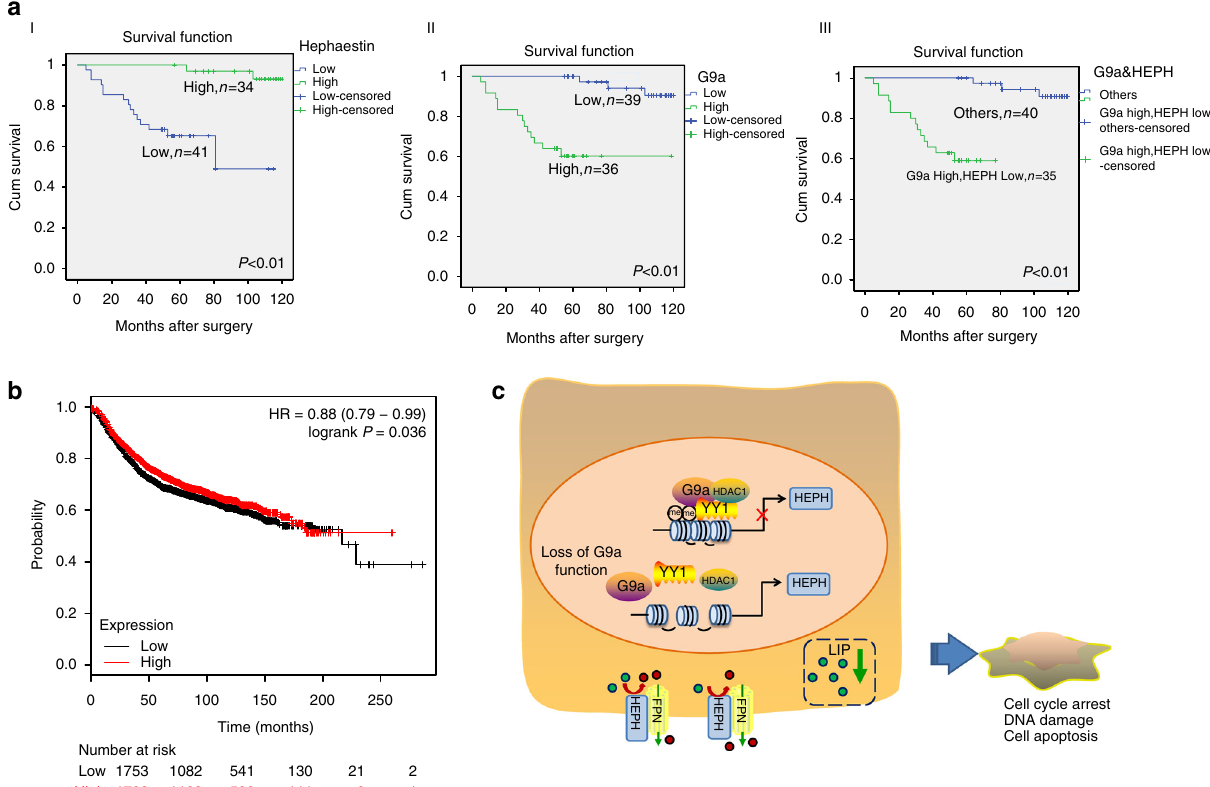
Fig. 7 High levels of G9a and low levels of HEPH correlate with poor survival in breast cancer. a G9a and HEPH prognostic interactions. Associations between OS and high or low G9a and HEPH expression levels (based on mean partitioning) in a combined multi-institutional population-based cohort consisting of 75 breast cancer cases. Kaplan – Meier plots and log-rank P -values are shown for (I) HEPH expression, (II) G9a expression, (III) high G9a dichotomized by low HEPH. b Public breast cancer database (KM-Plotter) was queried to examine the association between patients with breast cancer RFS and HEPH expression, the log-rank test P -value was indicated. c Schematic diagram depicting the regulation of HEPH in breast tumor cells. G9a as an HMTase activity-dependent repressor collaborates in the complex with YY1 and HDAC1, and works coordinately to contribute to the reduction of HEPH expression. Silencing of G9a upregulates HEPH, inhibits breast cancer cell proliferation and cell survival via upregulation of HEPH transcription and induces HEPH-mediated iron homeostasis disruption upon greater iron export. Green particles represent ferrous iron; red particles represent ferric